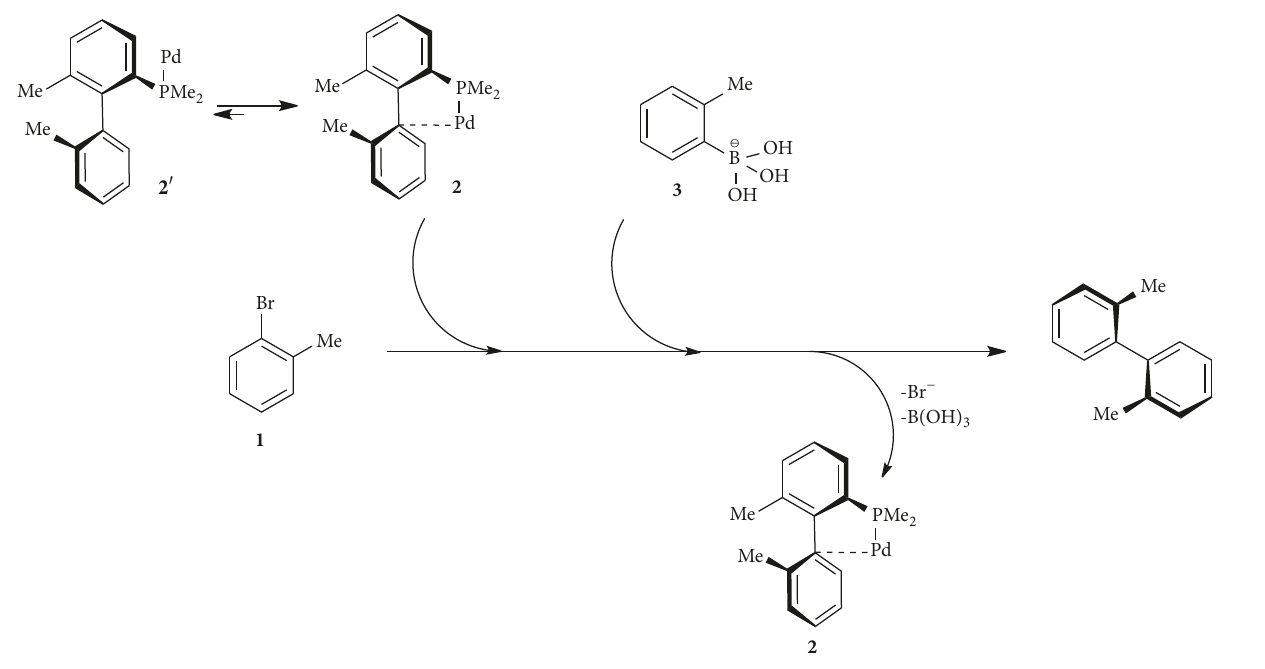
Scheme 3: Model coupling